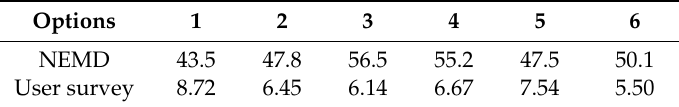
Table 3. NEMD and results of the user survey.